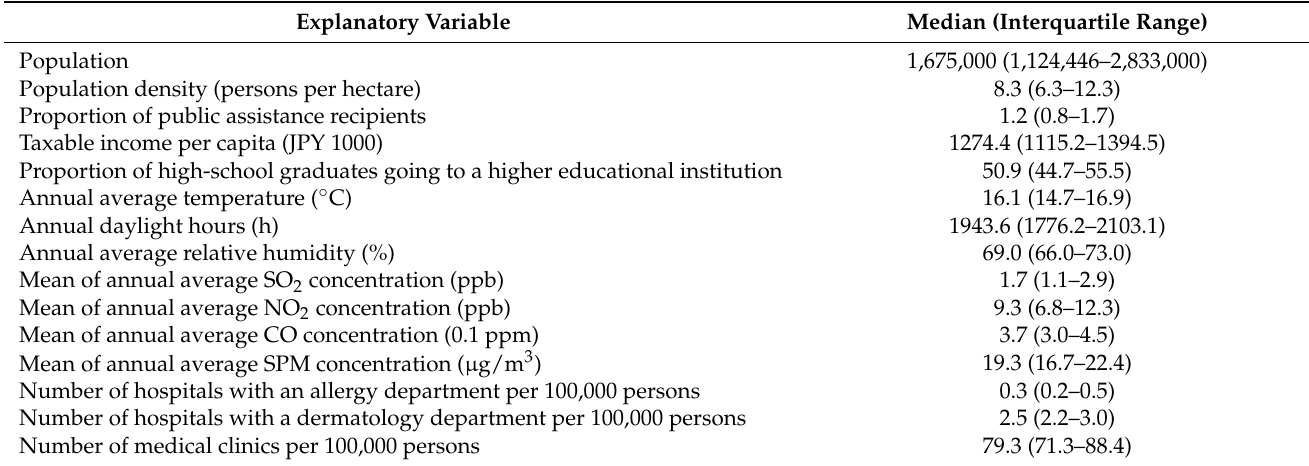
Table 4. Characteristics of explanatory variables used in this study.